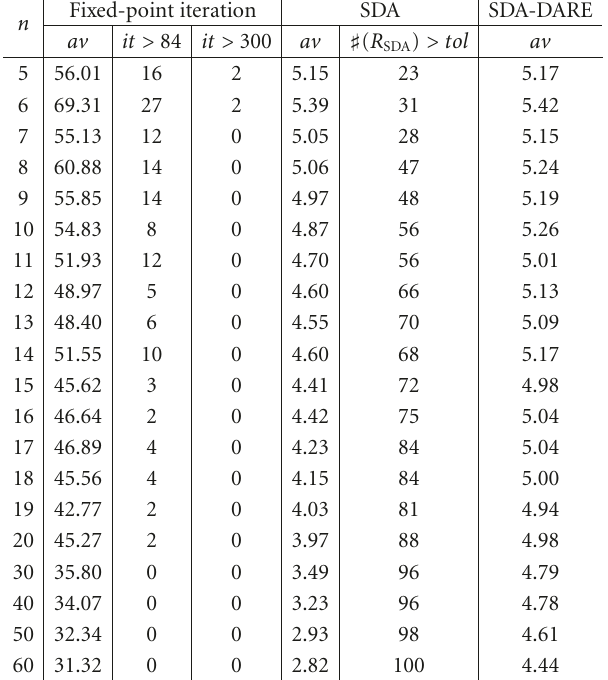
Table 2: Second set of test